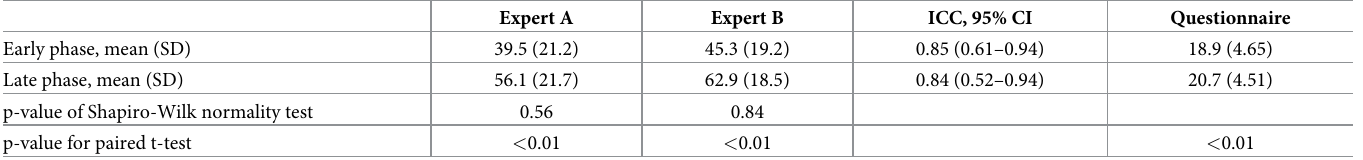
Table 4. Performance evaluation of cardiac ultrasound and acceptance for PoCUS program.